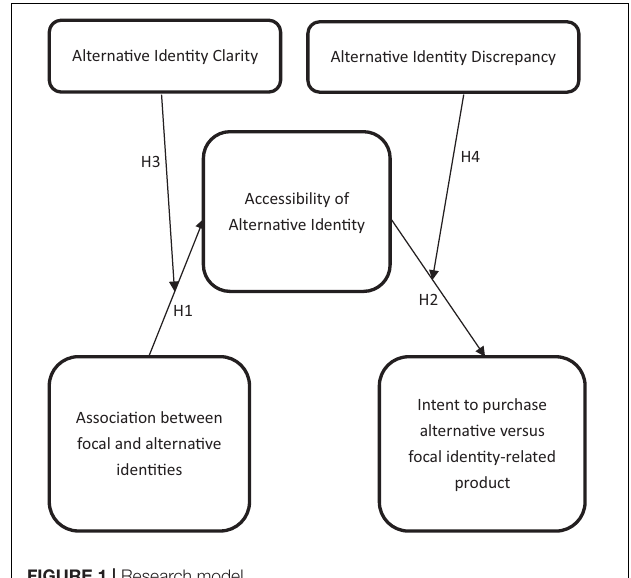
FIGURE 1 | Research